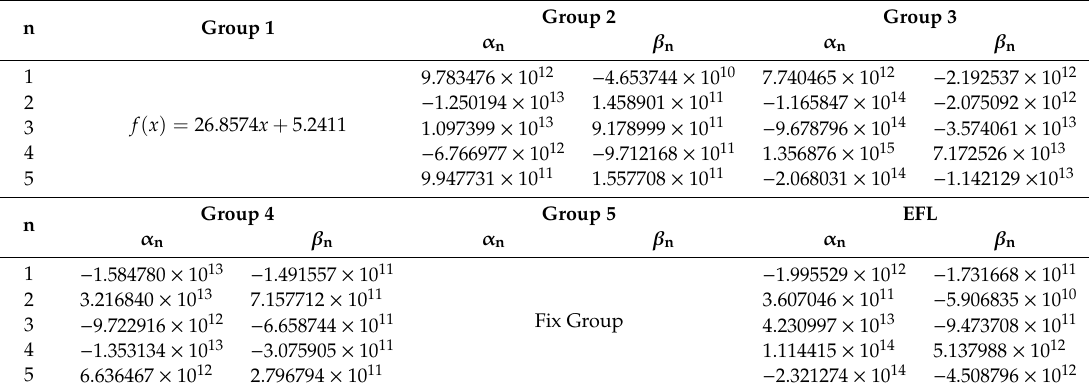
Table 12. Coe ffi cients of the rational function for each lens group calculated by the Pad é approximation shown in Table 11.